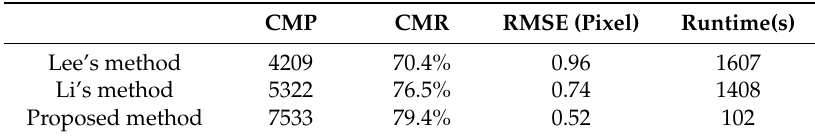
Table 4. Comparison of the three HR registration method on dataset